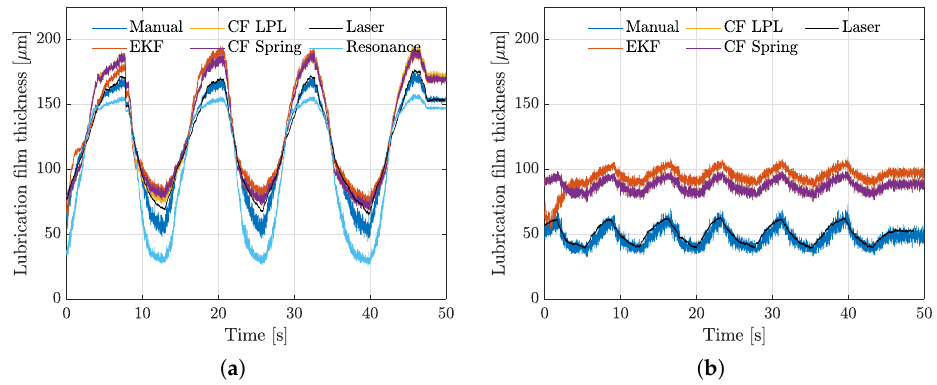
Figure 9. Average lubrication film thickness estimate using the layer phase-lag method. ( a ) Test 1. ( b ) Test 2.